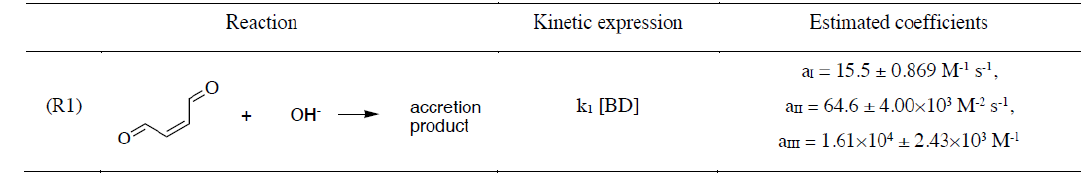
Table 2. Butenedial/OH − reaction, kinetic expression of the rate law, and corresponding estimates of the coefficients in the rate constant and their standard errors. a I and a III are well constrained. Although a II has a large standard error, it appears to not severely impact agreement between model and measurement (Fig. 3). See Eq. (1) for the expression of k 1 in terms of its coefficients, a I , a II , and a III , and OH − .